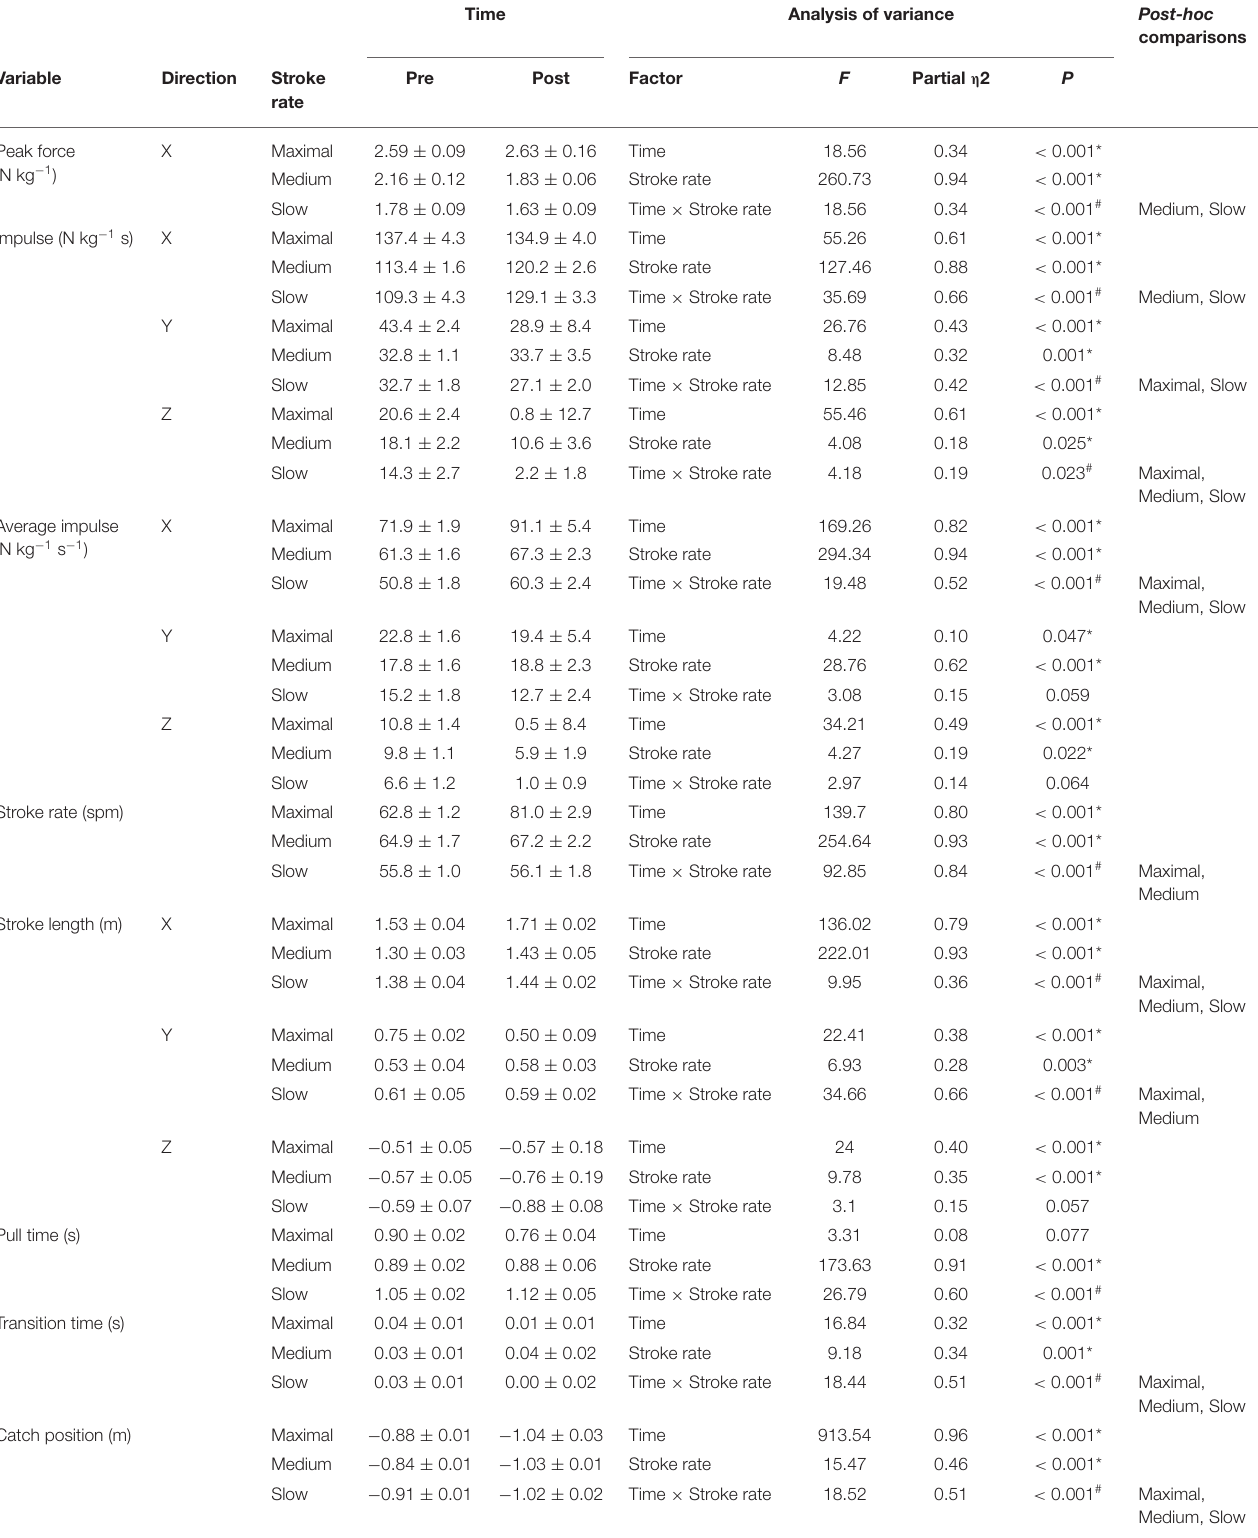
TABLE 1 | Effect of 4-week kayaking training on the paddling kinetics, paddling kinematics, and temporal parameters. Time Analysis of variance Post-hoc